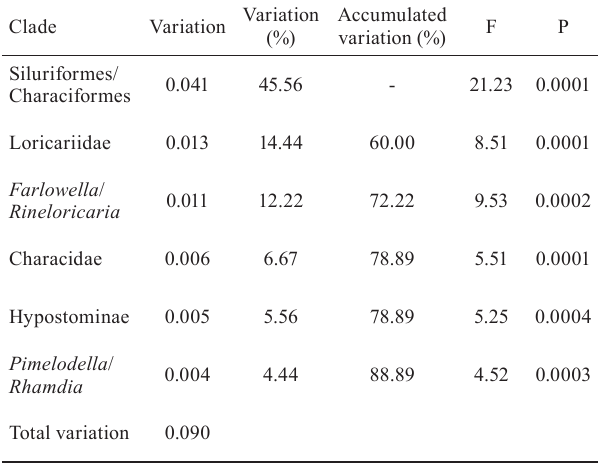
Table 3. Results of Monte Carlo permutations test on individual groups (defined as in Fig. 4) for the Y matrix of ecomorphological attributes. Percentage of the variation explained (with respect to total unconstrained variation) and F- and P- values for each group are given (9,999 permutations were used). Only significant groups are presented P ≤ 0.002 (according to the Bonferroni